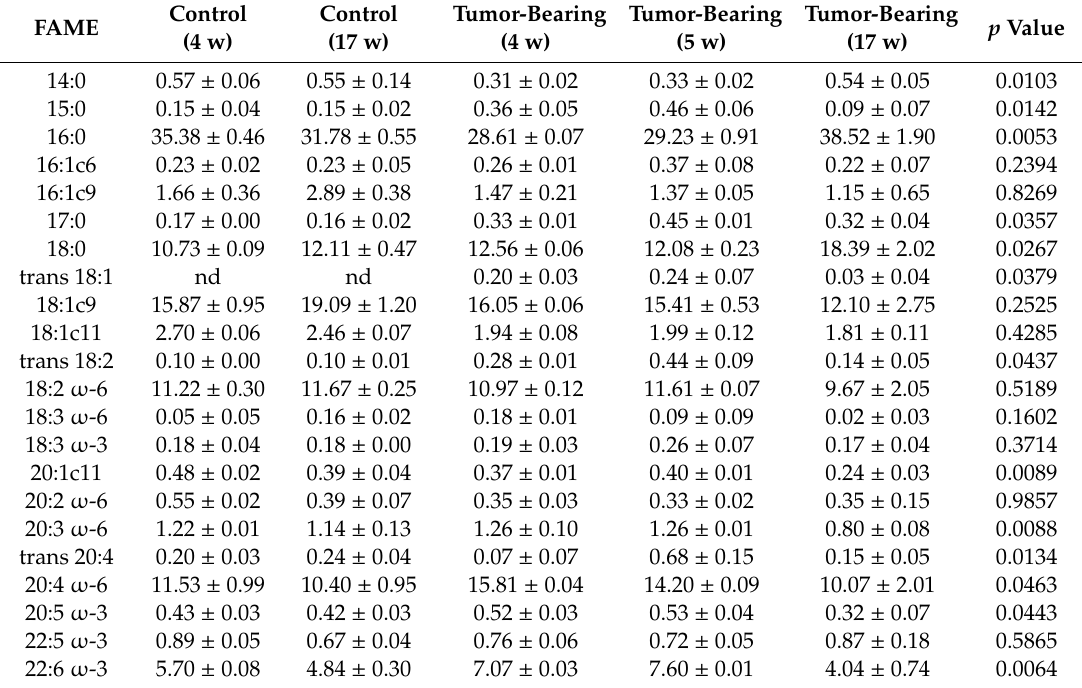
Table 3. Relative percentages (% rel) of fatty acid methyl esters (FAME) from red blood cell (RBC) membrane of control SCID mice at di ff erent age points (4 weeks and 17 weeks) and tumor-bearing SCID mice at di ff erent age points (4 weeks, 5 weeks and 17 weeks).